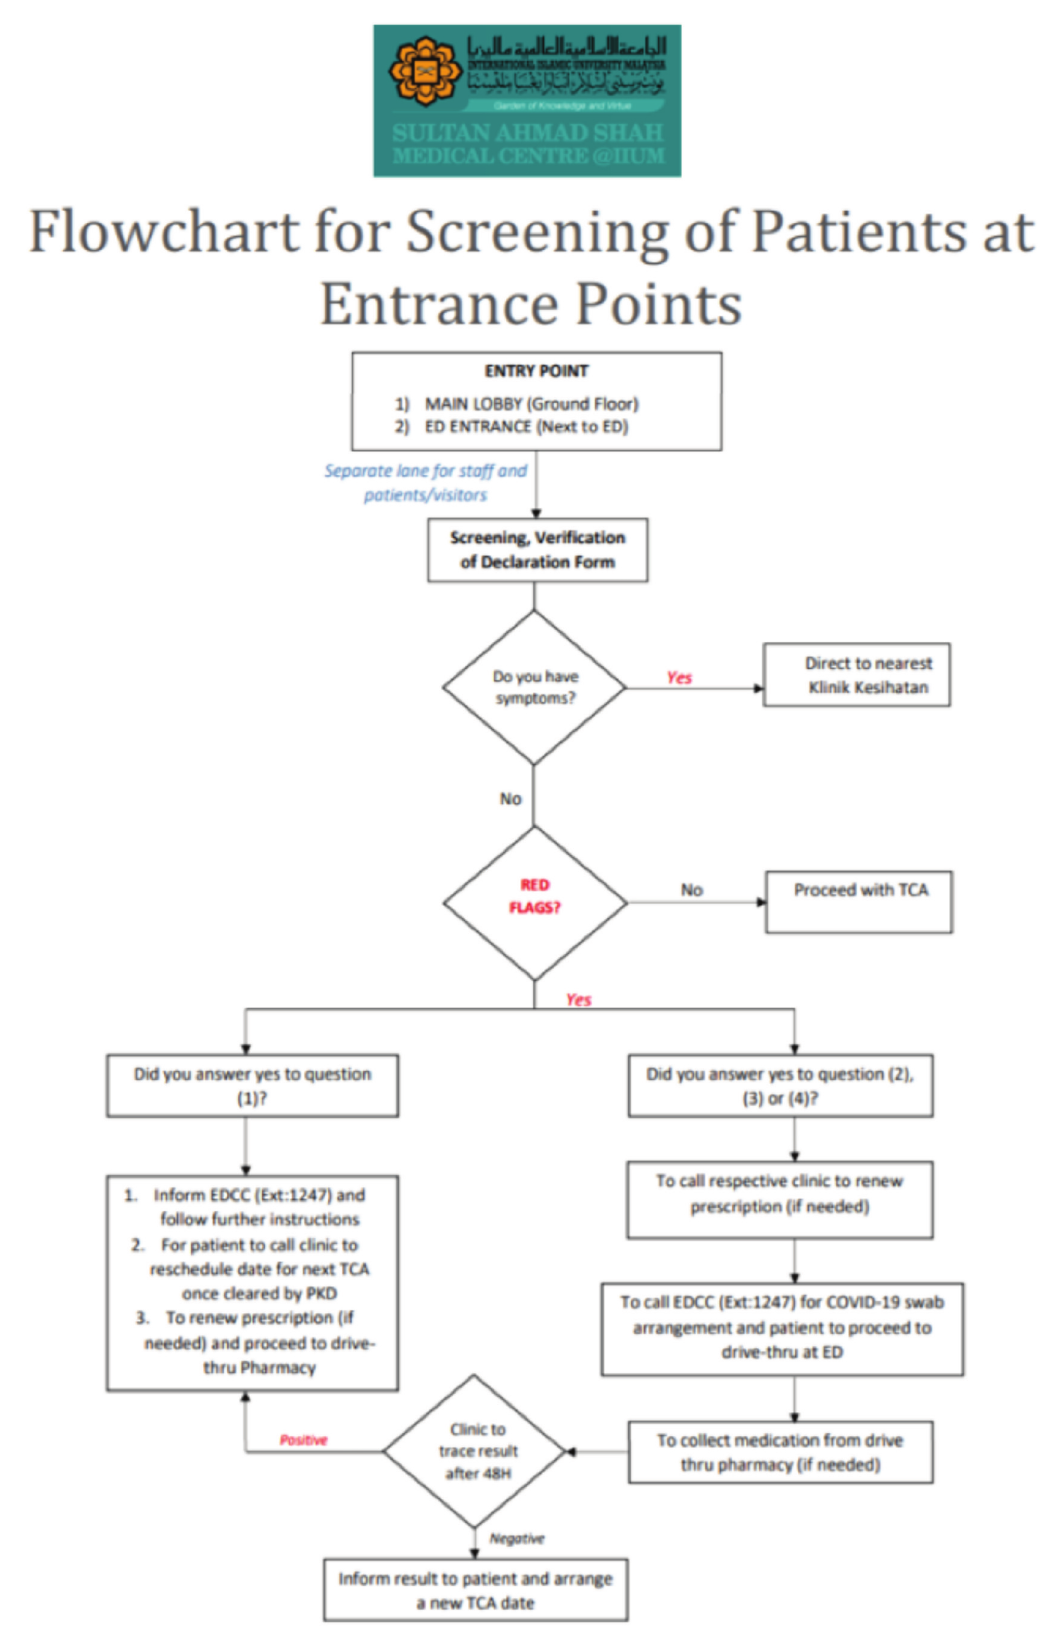
Flowchart for screening of patients at entrance points at Sultan Ahmad Shah Medical Centre Fig. 3: